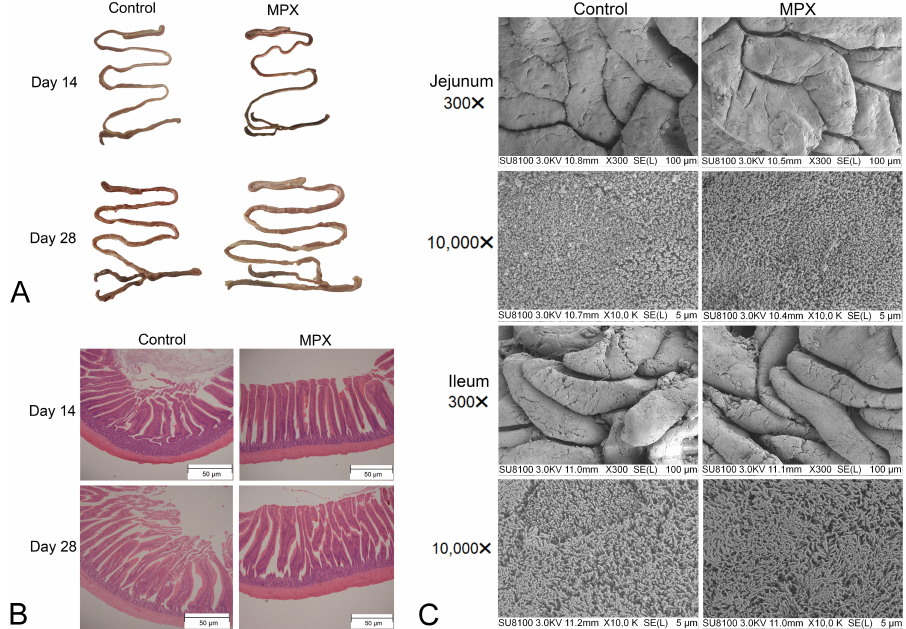
Figure 1. Observation of the intestinal morphology and intestinal villus morphology after MPX supplementation. ( A ) Necropsy observation of the intestinal pathology. ( B ) H&E staining revealed pathological changes in the jejunum. ( C ) Scanning electron microscopy was performed to observe the morphological changes in the villi and microvilli of the jejunum and